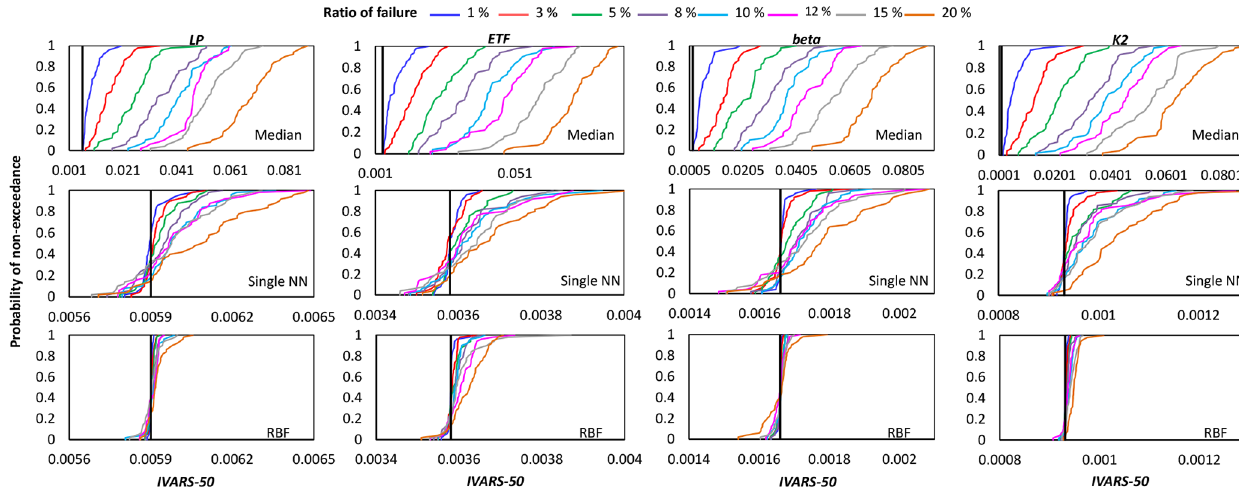
Figure 6. Comparison of the proposed crash-handling strategies in a sensitivity analysis of the HBV-SASK model using the STAR-VARS algorithm for different ratios of failure. The CDFs of the sensitivity indices for weakly influential parameters ( LP , ETF , beta , K2 ) are shown in this plot. The vertical line (solid black) on each subplot represents the corresponding “true” sensitivity index obtained when there were no failures.